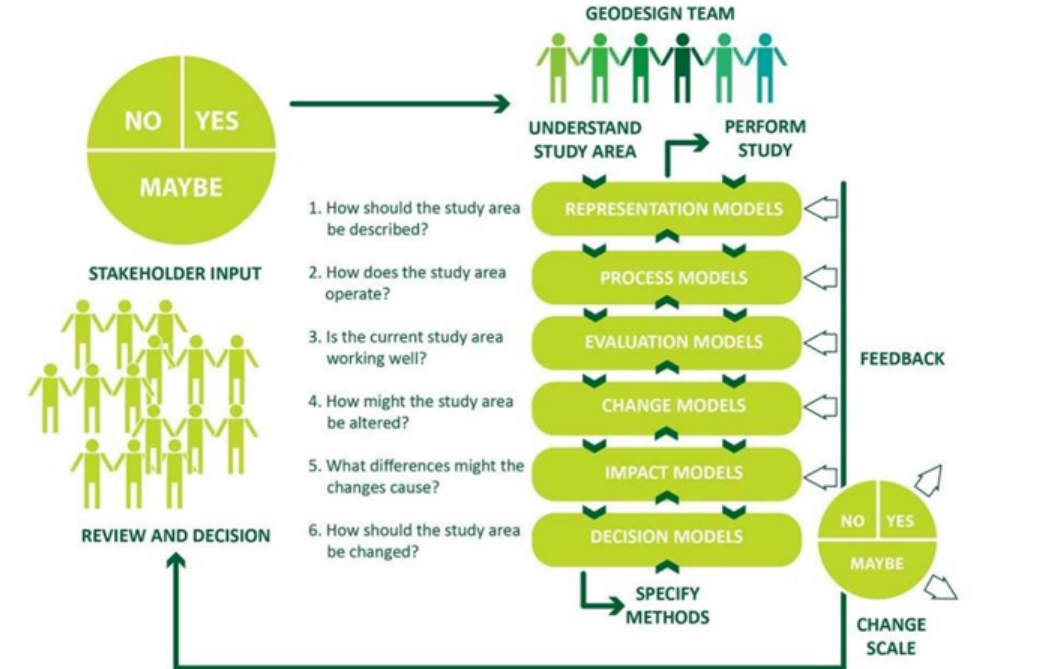
Figure 1. Geodesign framework (Steinitz, 2012). Graphic by author Libera Amenta.